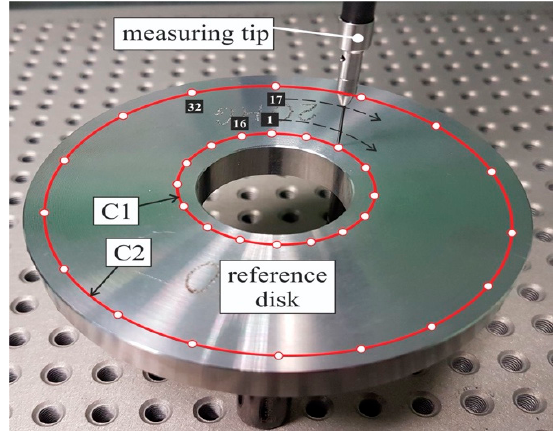
Figure 1. Arrangement of measuring points during measurement to determine flatness.